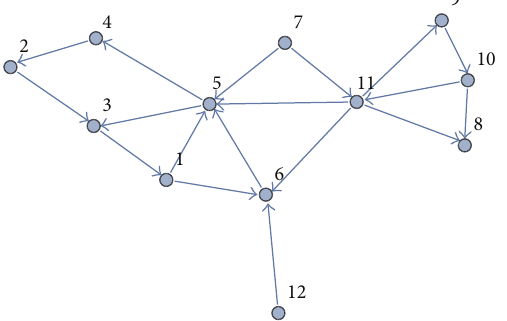
Figure 2: Chaotic behavior of delayed Chua